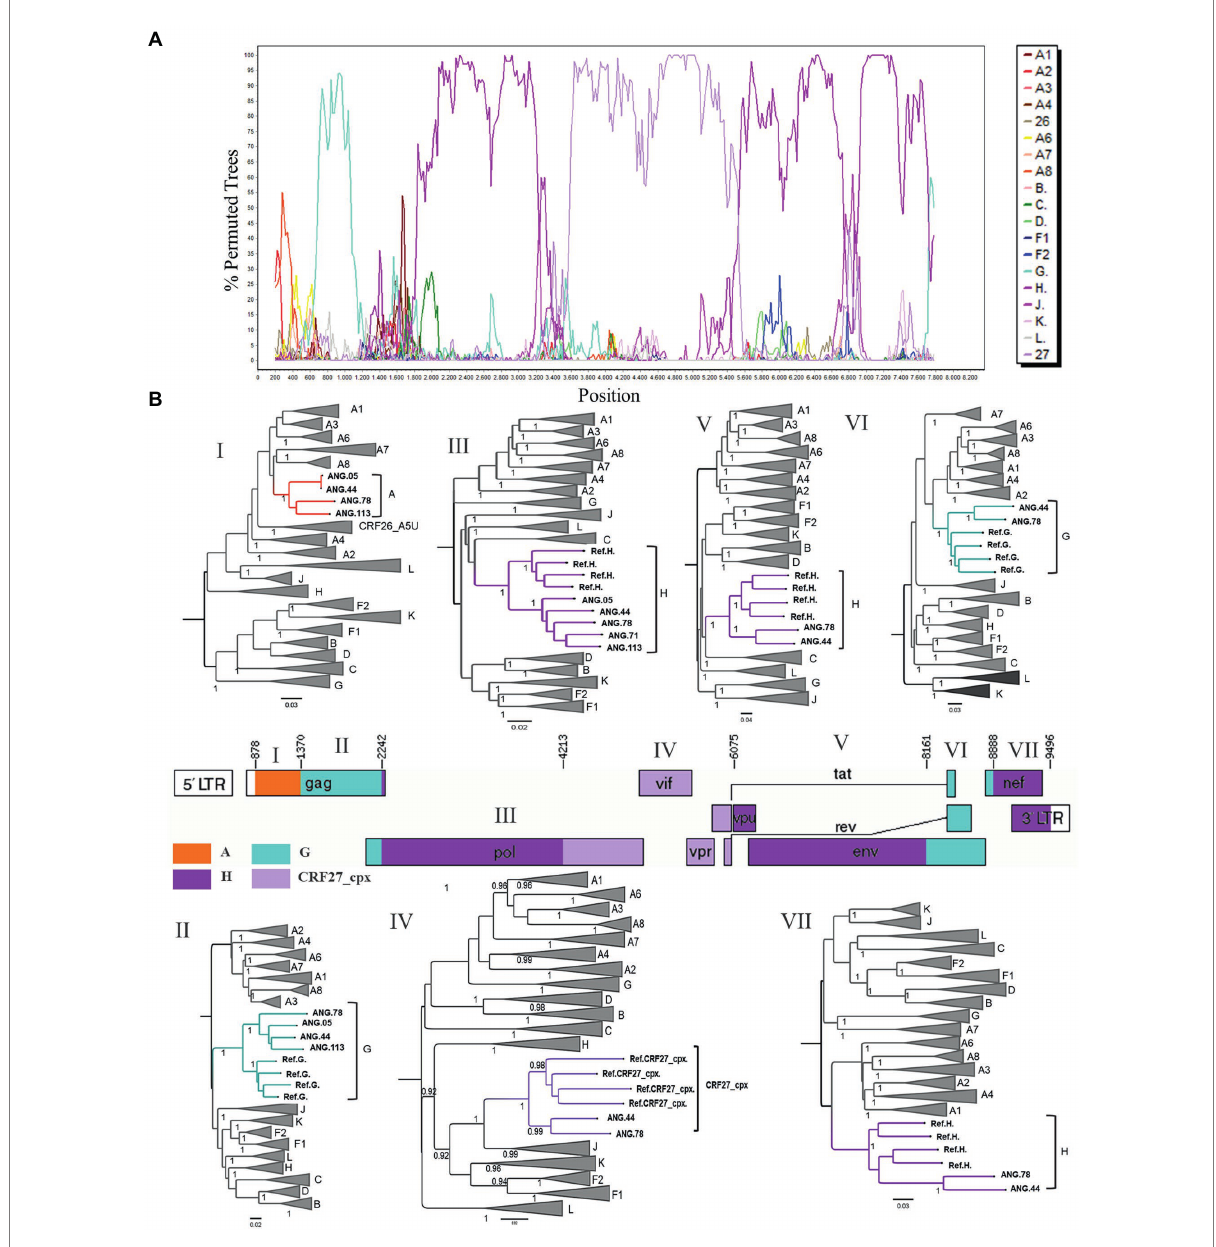
FIGURE 2 Determination of the new circulating recombinant form (CRF) among HIV-1 samples circulating in Angola. (A) Bootscan analysis of the sequence ANG.44 was performed in SimPlot software using a 400 nt sliding window and 20 nt increments. (B) Genomic structure of CRF124_cpx colored according to the HIV-1 subtyping. The mosaic map was generated using the Recombinant HIV-1 Drawing Tool (https://www.hiv.lanl.gov/content/ sequence/DRAW_CRF/recom_mapper.html). The maximum likelihood tree (ML) was performed to confirmation of the HIV-1 subtype of each fragment. ML tree implementing nucleotide substitution model General Time Reversible (GTR), indicating the phylogenetic relationships between pure HIV-1 subtypes and CRF124_cpx sequences. ALRT values were represented only if